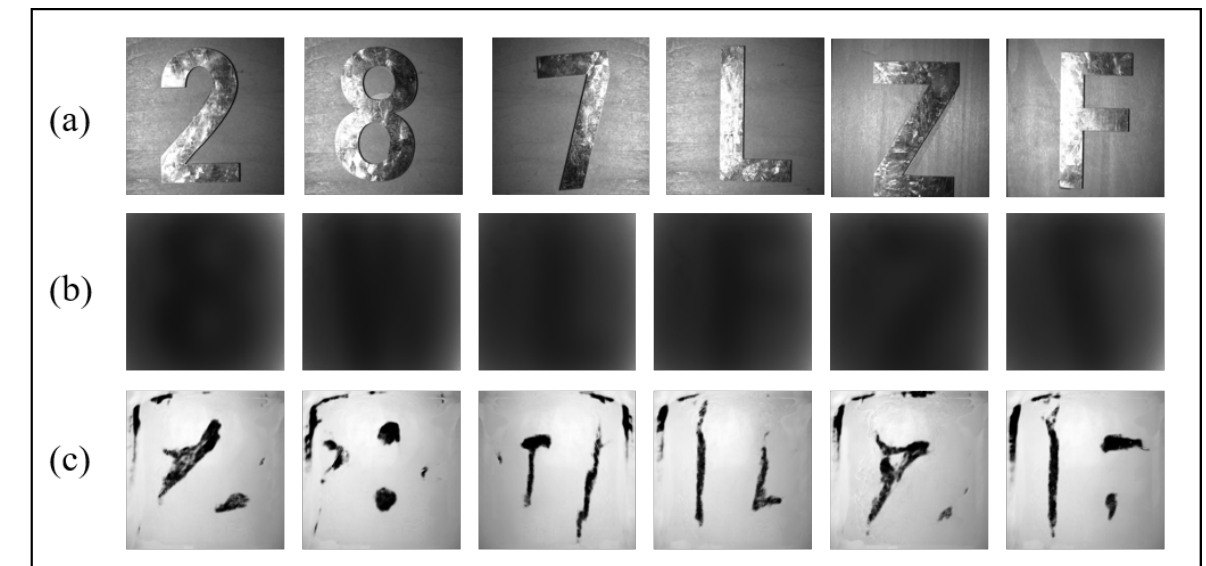
Figure 9. The test results of model-DoP for the untrained target and background materials. ( a ) Ground truth with target-background as Steel–Wood; ( b ) Scattering DoP images; ( c ) Reconstructed images by the Model-DoP.